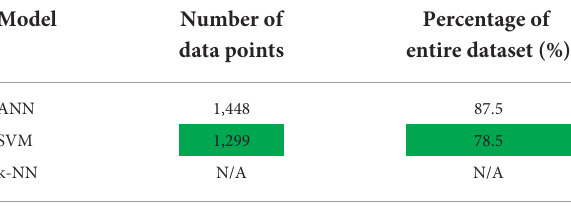
TABLE 5 Data points required to obtain a 5% average error.